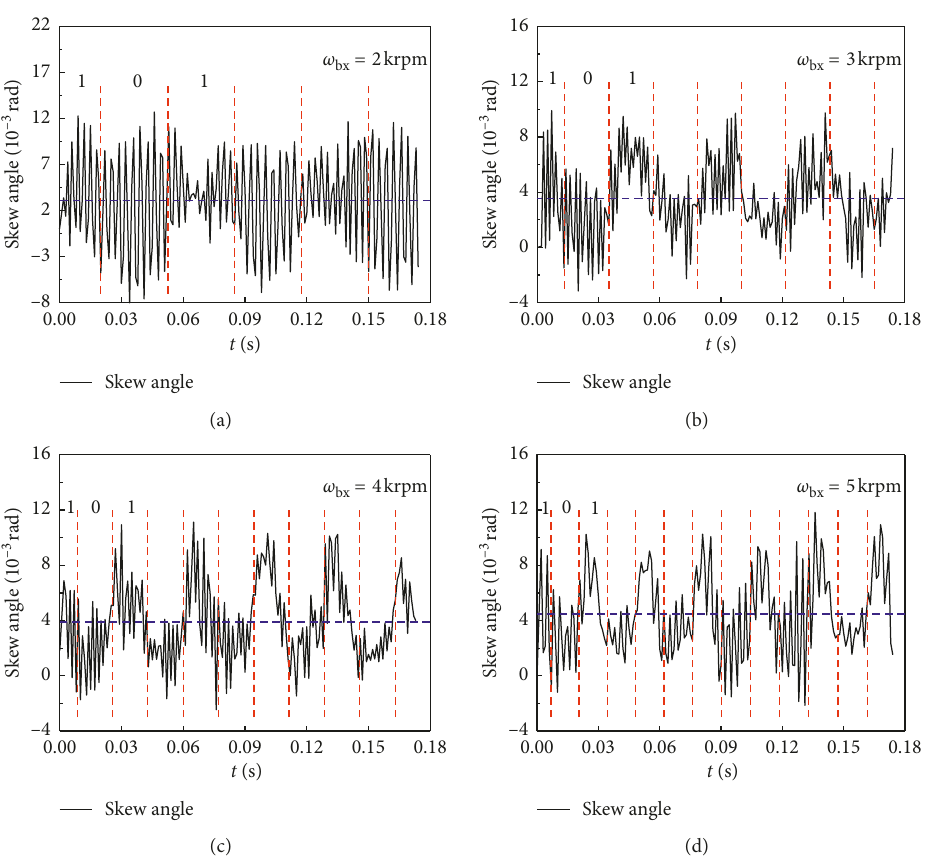
Figure 7: The skew angle of the conical roller. 1: loaded zone; 0: unloaded zone. F